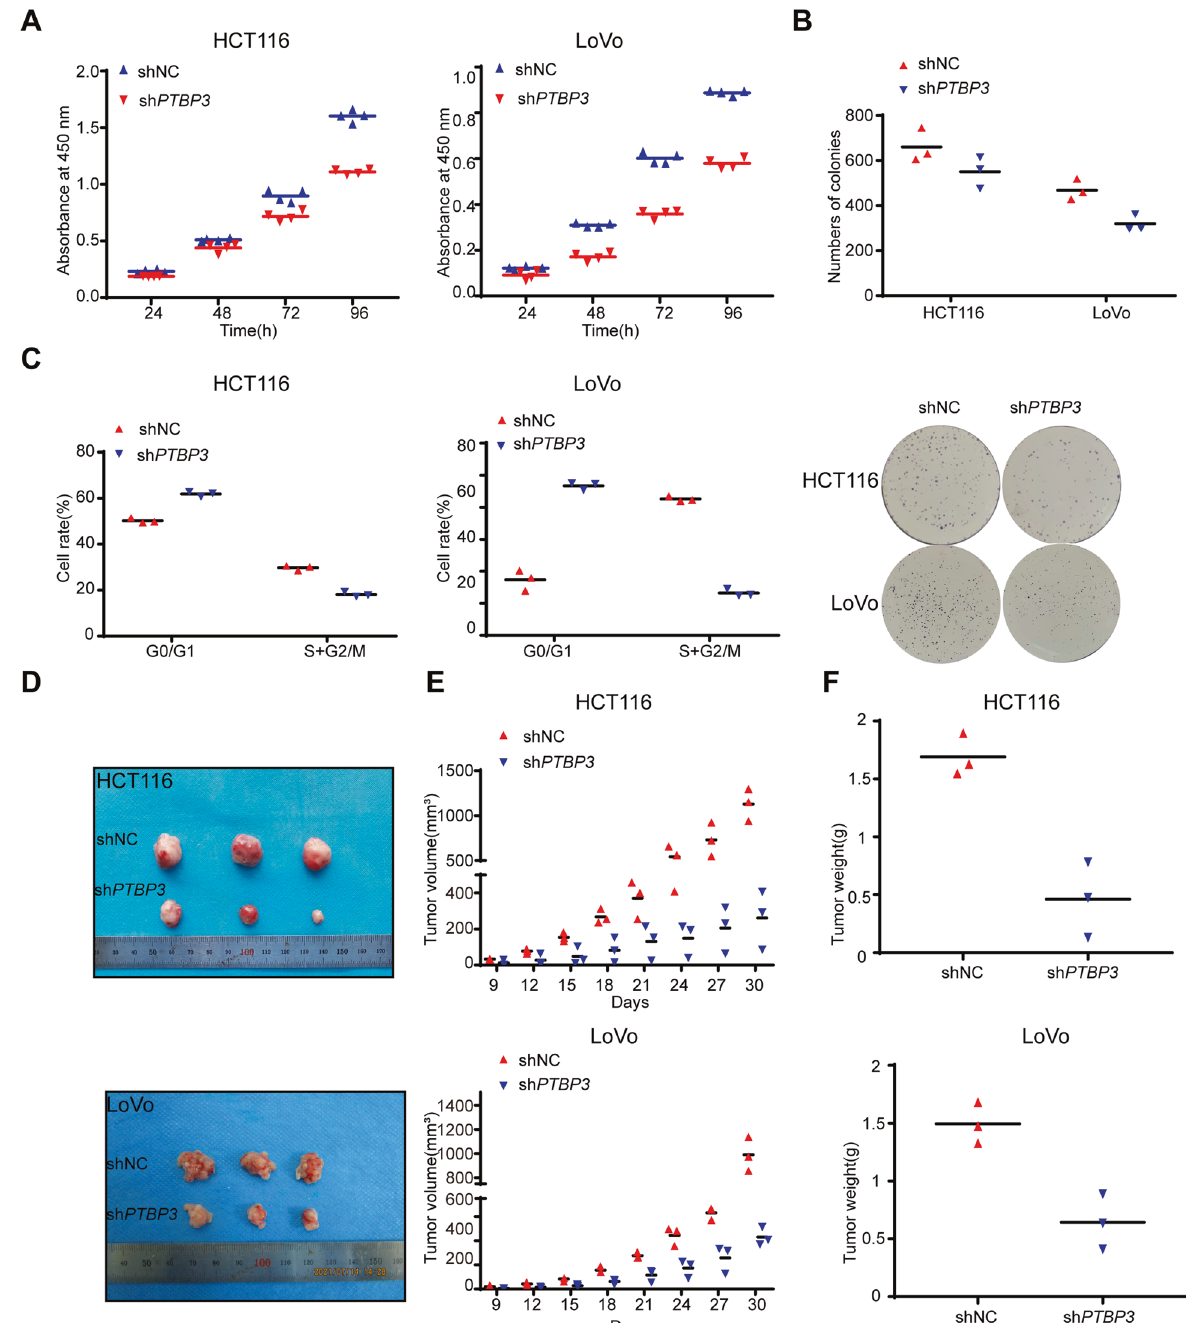
Fig. 2 PTBP3 promotes CRC cell proliferation in vitro and in vivo. A Reduction in the proliferation ability of sh PTBP3 HCT116 and LoVo cells compared with that of control (NC) cells using the CCK-8 assay (two-way ANOVA, P < 0.01). B Reduction in the colony formation ability of sh PTBP3 HCT116 and LoVo cells compared with that of control (NC) cells using the colony formation assay. The bar graph indicates the number of colonies (two-tailed Student ’ s t -test, P < 0.01). C Cell cycle distribution of sh PTBP3 HCT116 and LoVo cells compared with that of control (NC) cells by fl ow cytometry (two-tailed Student ’ s t -test, P < 0.0001). D Images of xenograft-transplanted nude mouse models ( n = 3) and dissected tumors 30 days after injection with sh PTBP3 HCT116 and LoVo cells and their corresponding NC cell lines. E Xenograft tumor growth curves of sh PTBP3 HCT116 and LoVo cells and their corresponding NC cell lines (two-tailed Student ’ s t -test, P < 0.05). F Xenograft tumor weight of sh PTBP3 HCT116 and LoVo cells and their corresponding NC cell lines. The results are presented as means ± s.d. and are representative of at least three independent experiments (two-tailed Student ’ s t-test, P < 0.01).